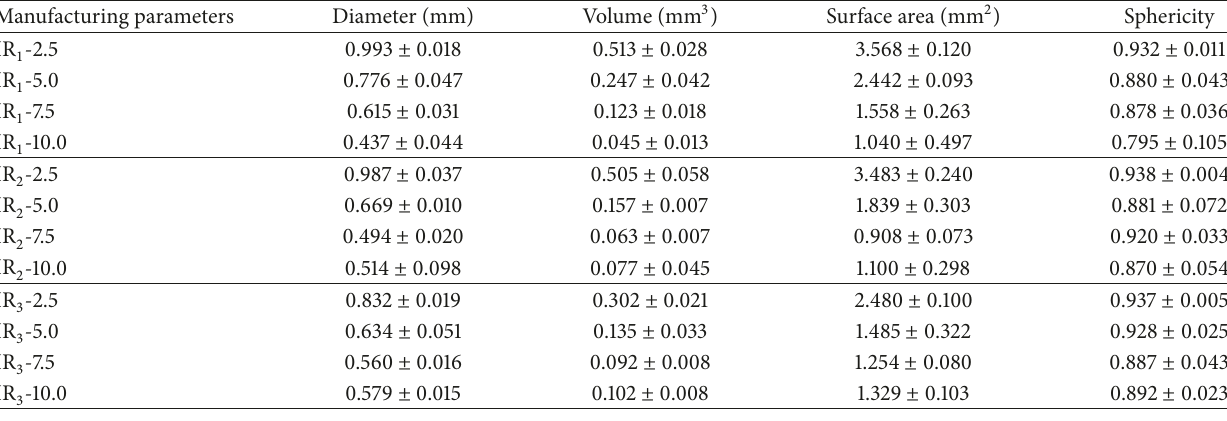
Table 2: Size of chitosan microspheres.